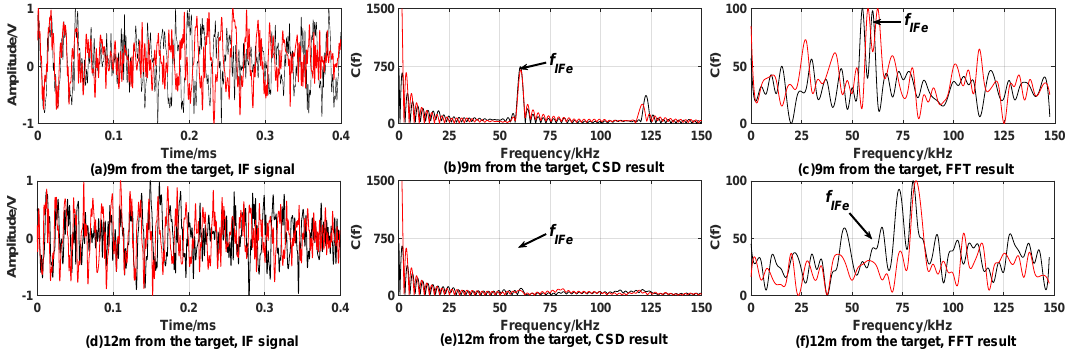
Figure 7. Simulation results when the target is covered by smoke with expected distance 3 m. When fuze is 3 m away from the target, ( a ) is time domain waveform of IF signal; the processing result of CSD algorithm and FFT algorithm are ( b , c ), respectively. When fuze is 5 m away from the target, ( d ) is time domain waveform of IF signal; the processing results of CSD algorithm and FFT algorithm are ( e , f ), respectively.